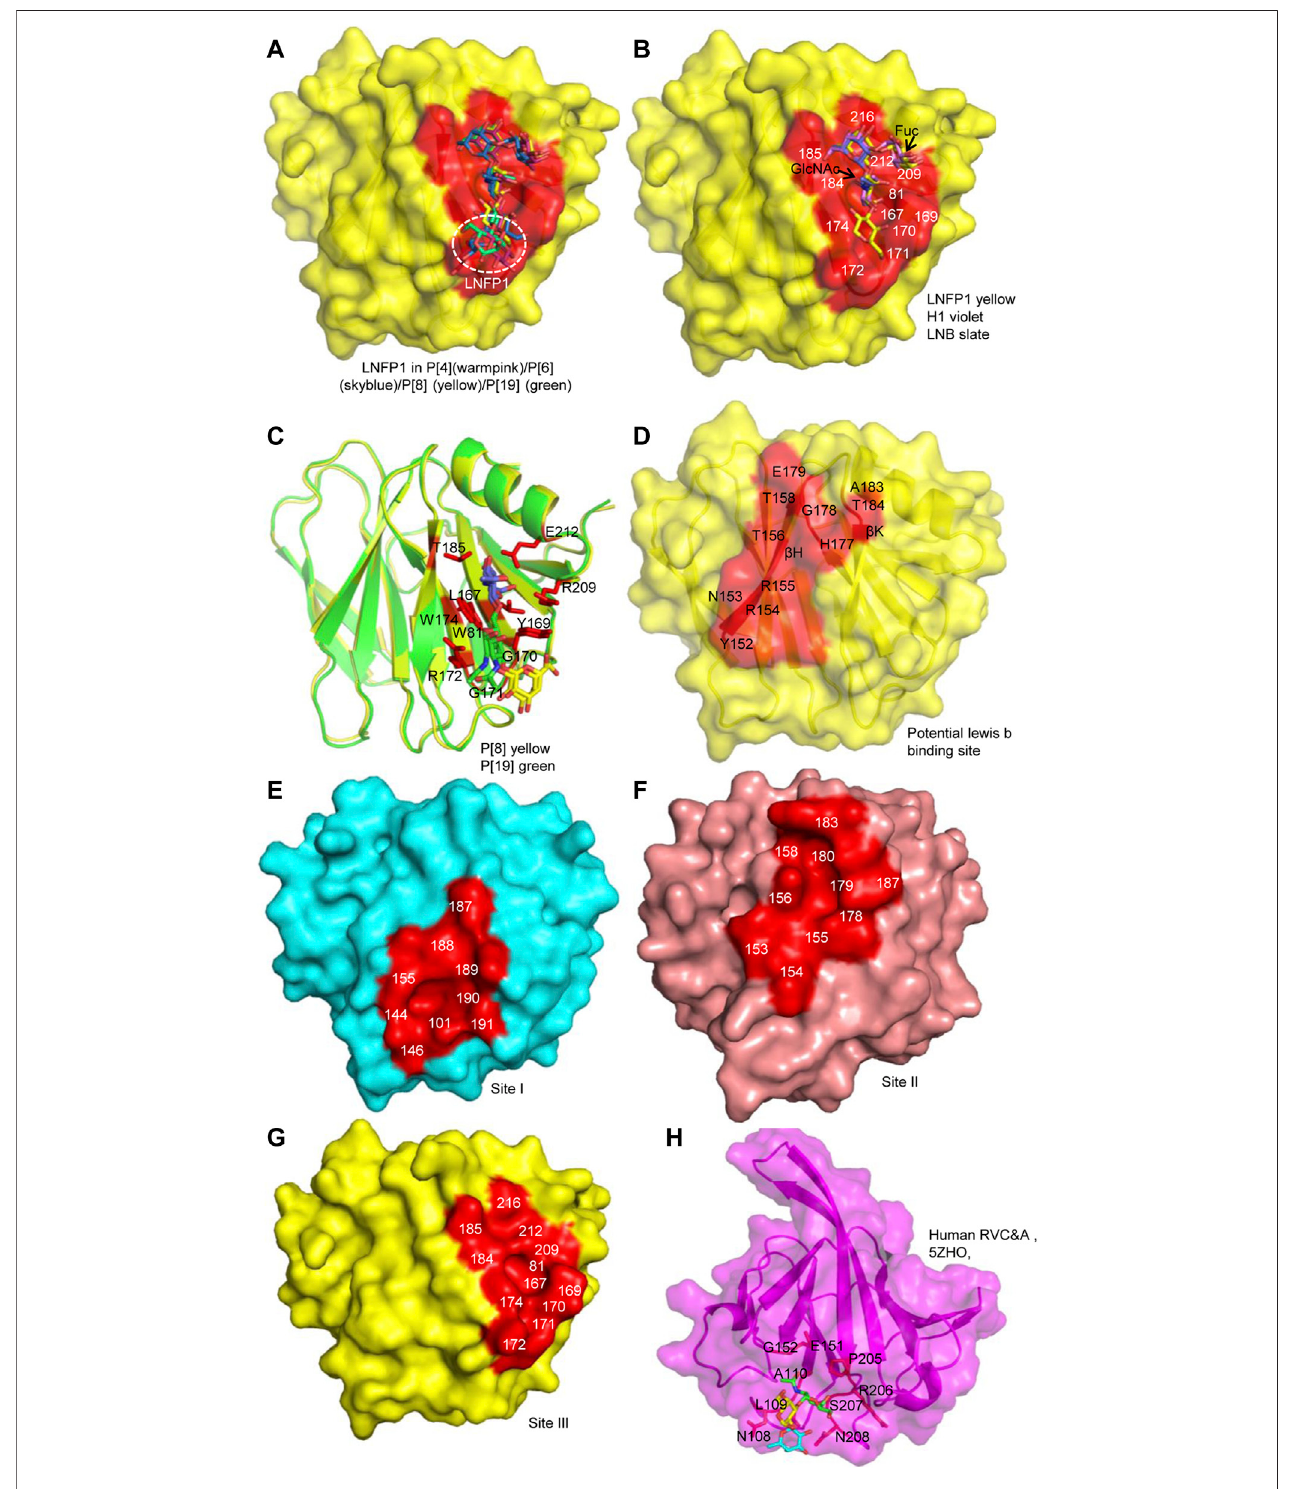
FIGURE 5 | Comparison of the glycan binding sites. (A) The superimposition of LNFP1 that bound to P[4]/P[6]/P[8]/P[19] VP8*s. (B) Superimposition of type 1 HBGAs (H1, LNB, LNFP1) that located at the same glycan binding site of P[8] VP8*. (C) The interactions between P[8]/P[19] VP8* and mucin core 2. (D) The potential lewis b binding site in P[8] VP8* based on NMR. (E – G) Surface presentation of the three distinct glycan binding sites in RVA VP8*s. The residues constitute the glycan bindingsitewerelabeled.P[14] (cyan,4DRV),humanP[11] (salmon,4YG0),P[8](yellow,6K2O)VP8*sarepresented asmodels. (H) Thepresentationoftheglycan binding site of human group C RV (RVC) VP8* (magenta, PDB ID: 5ZHO). Type A trisaccharide was shown as stick. The residues involved in the glycan binding site are labeled.